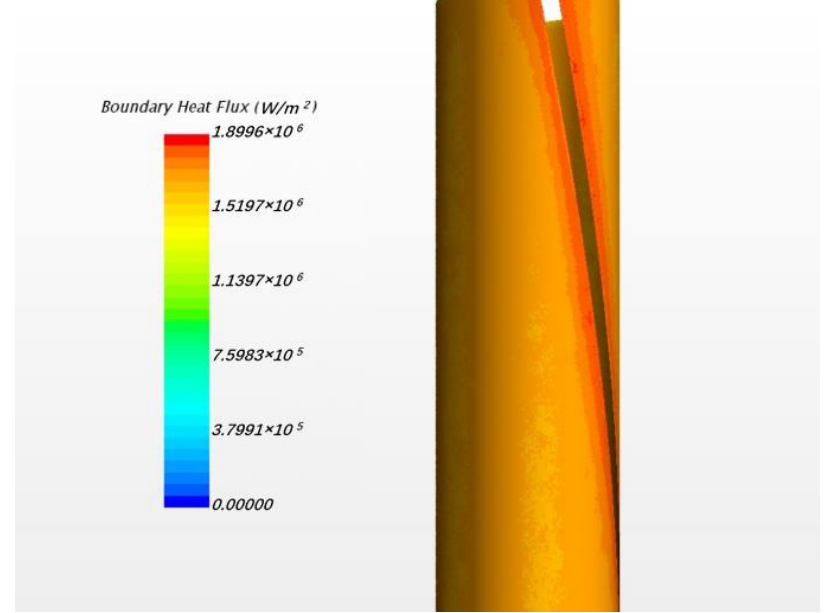
Figure 18. The surface heat flux of the rod.